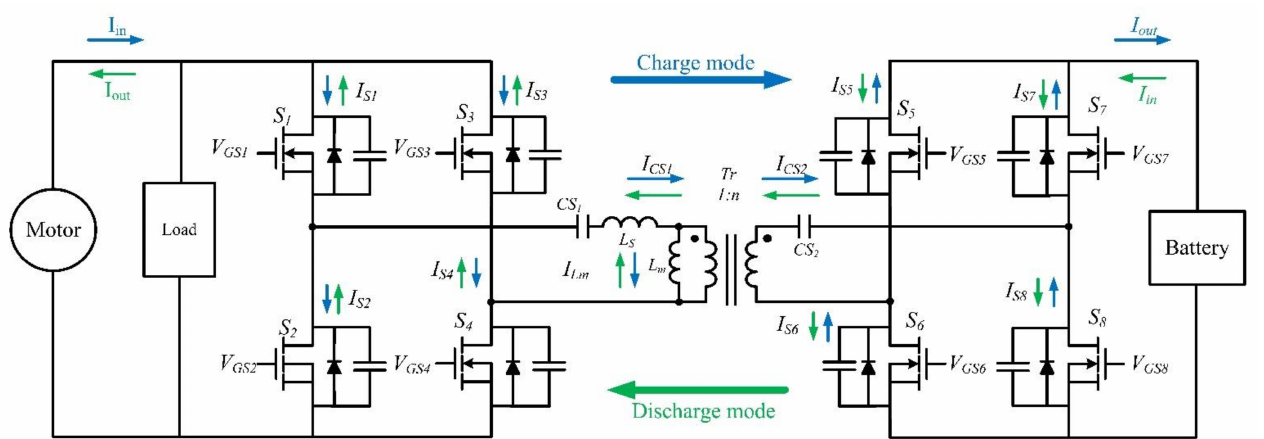
Figure 4. Circuit diagram of the realized bidirectional full-bridge LLC resonant